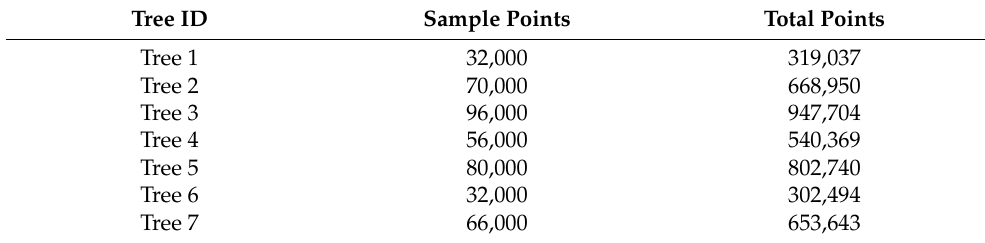
Table A1. The sample size of seven trees for model